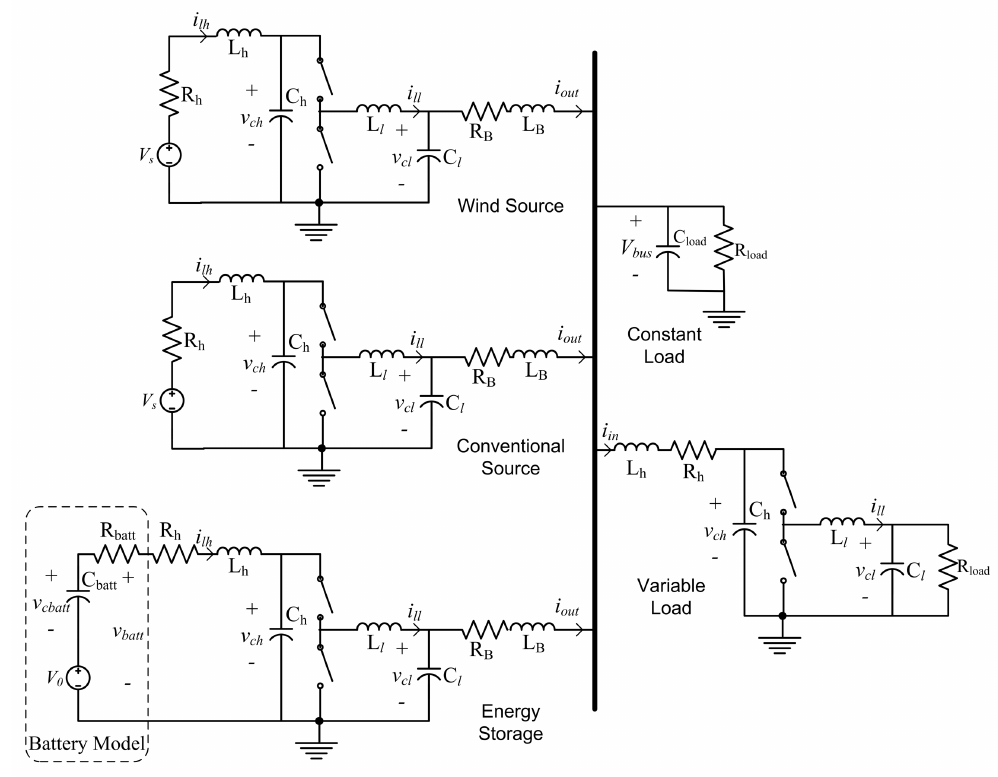
Figure 13. Example microgrid for the demonstration of droop control